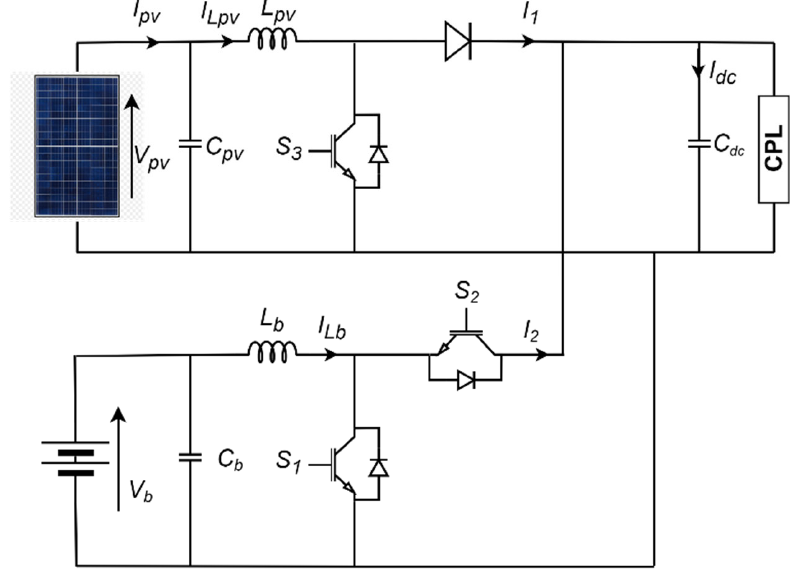
Figure 2. The studied DC microgrid.